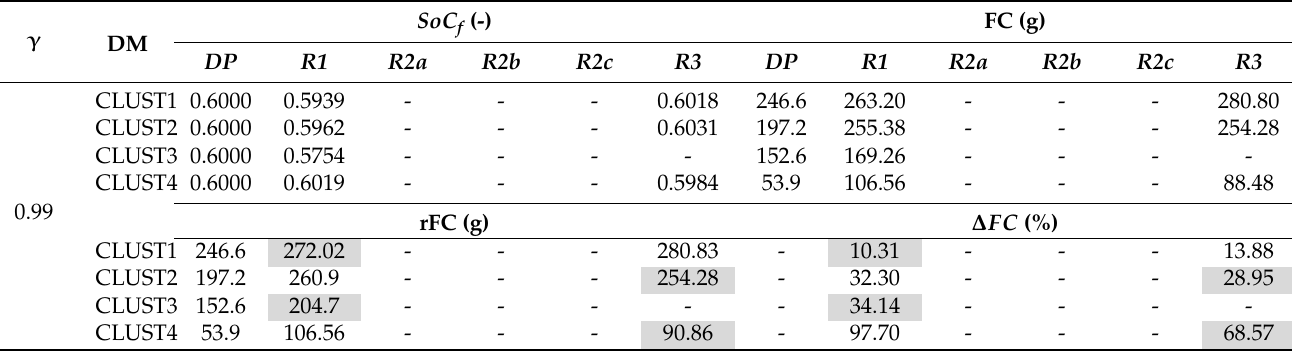
Table 4. Reward shaping analysis considering γ =